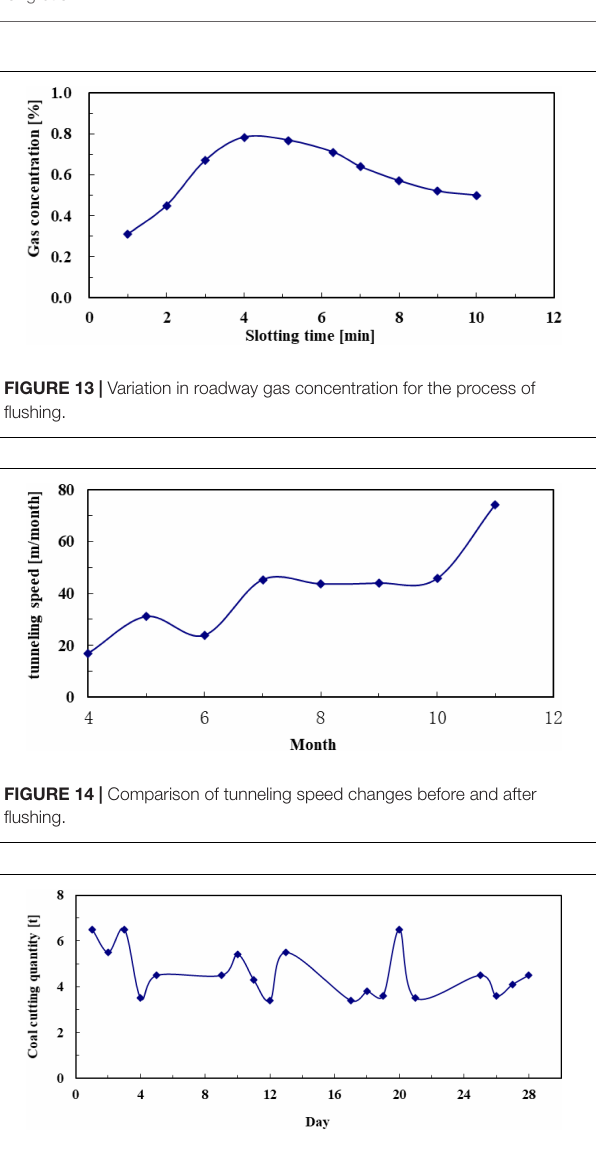
FIGURE 15 | Variation in coal cutting quantity for the process of